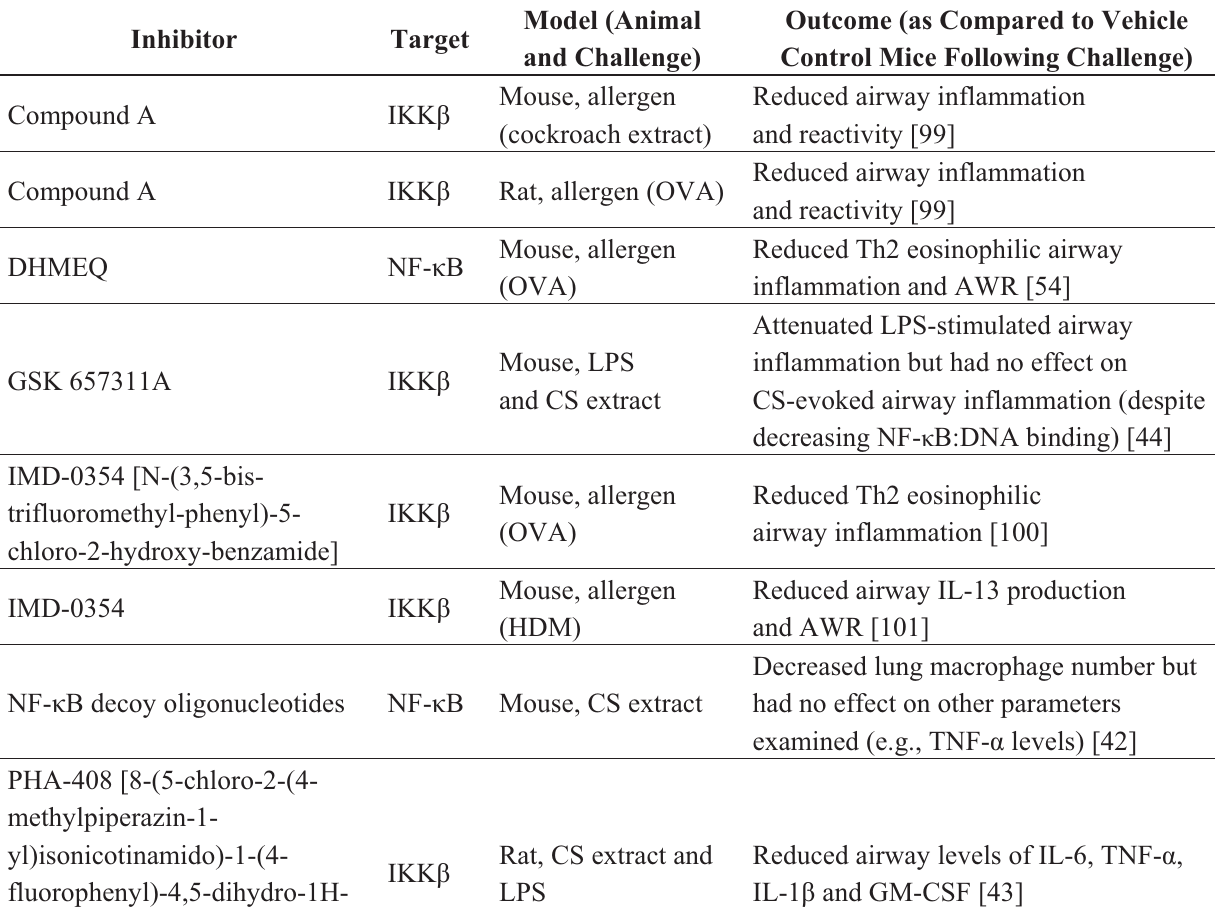
Figure 1. Direct targets of nuclear factor (NF)-kappaB (NF-(cid:2)B) signaling. Table 2. A summary of findings from studies that have targeted NF-(cid:2)B intermediates in rodent experimental models of asthma and chronic obstructive pulmonary disease